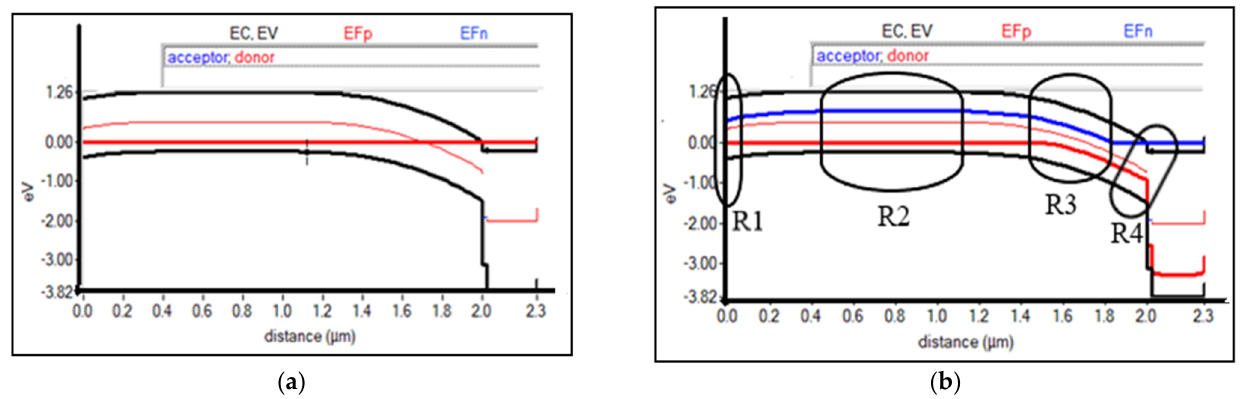
Figure 8. The band energy diagram CdTe layer (acceptor). ZnSe layer (buffer) and SnO 2 layer window; ( a ) dark current, ( b ) photo current.